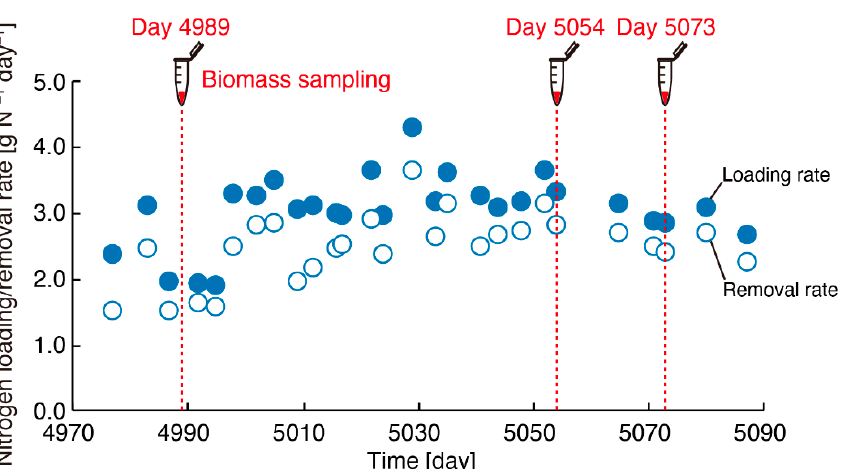
Figure 1. Nitrogen removal performance of the up-flow column reactor. Filled and open circles represent the nitrogen loading and removal rate, respectively. Biomass samples were collected on days 4989, 5054, and 5073.